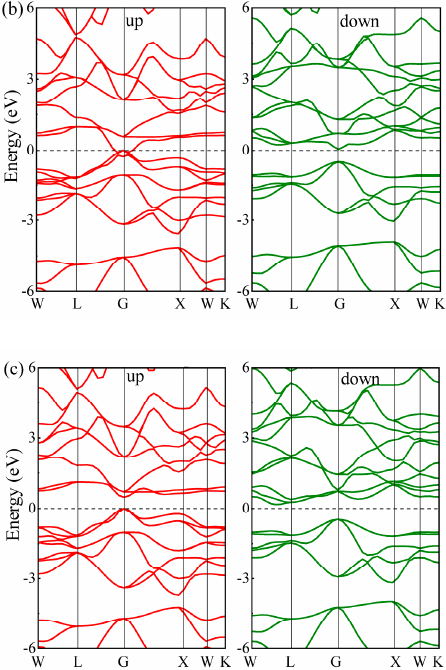
Figure 6. Energy band diagram of ( a ) VFeScSb, ( b ) VFeScAs, and ( c ) VFeScP with type-I structure.